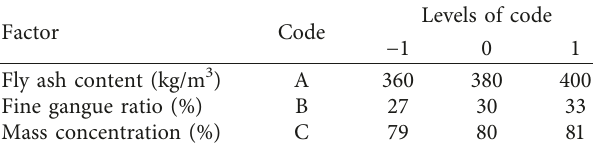
Table 2: Levels of factors of RSM.